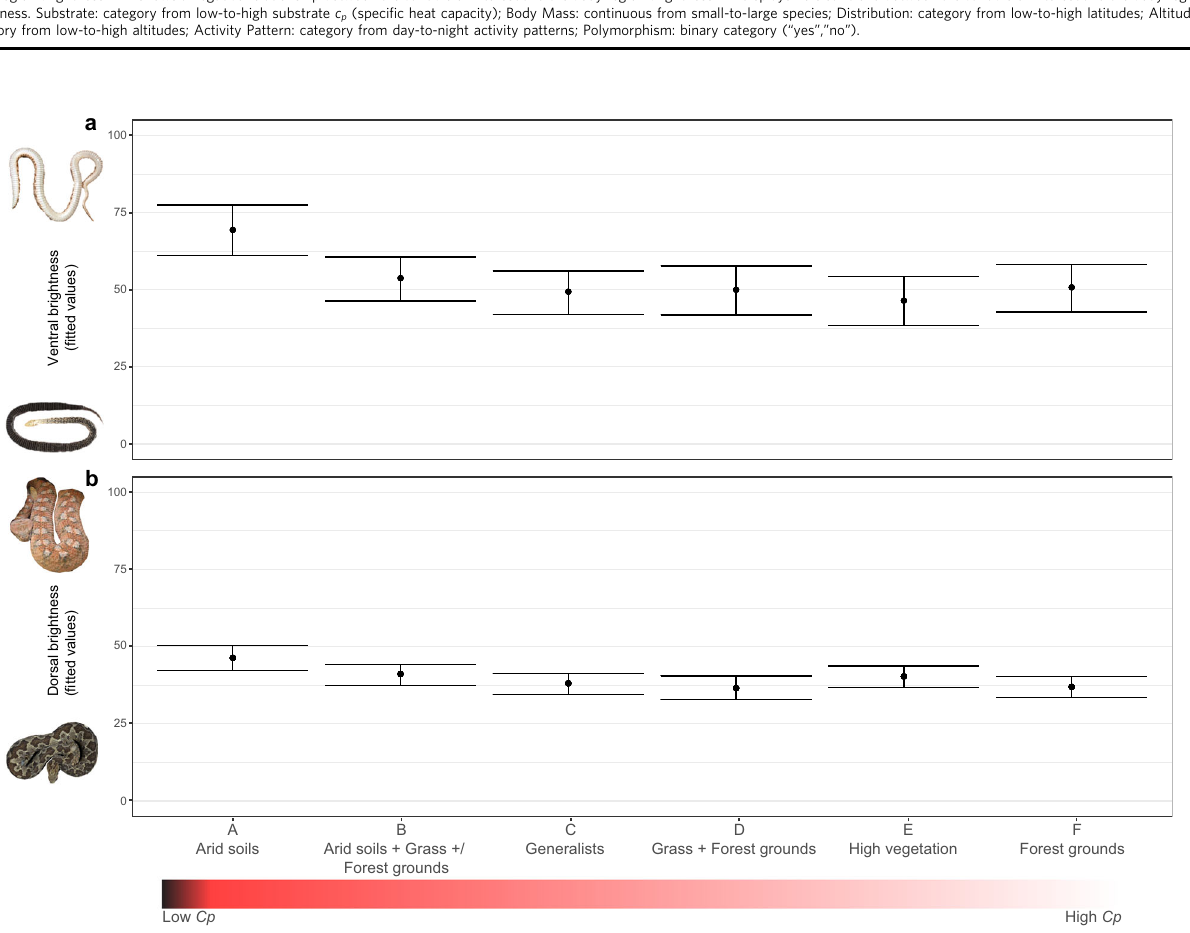
Fig. 2 Brightness variation across different body regions and substrate types. MCMCglmm-predicted values of ventral ( a ) and dorsal ( b ) brightness across the six different substrates. Bars represent 95% credible intervals. c p = Speci fi c Heat Capacity. Generalists are species occurring on more than three different types of substrates. For a full description of substrate classi fi cation see Methods. Credits: Echis leucogaster (© Gabri Mtnez, moroccoherps.com — with permission), Gloydius ussuriensis (Orlov, N.L. et al. 90 ), Echis coloratus (Wikipedia CC BY-SA 3.0), Atropoides picadoi (© Gert Jan Verspui, INaturalist, CC BY-NC 4.0).